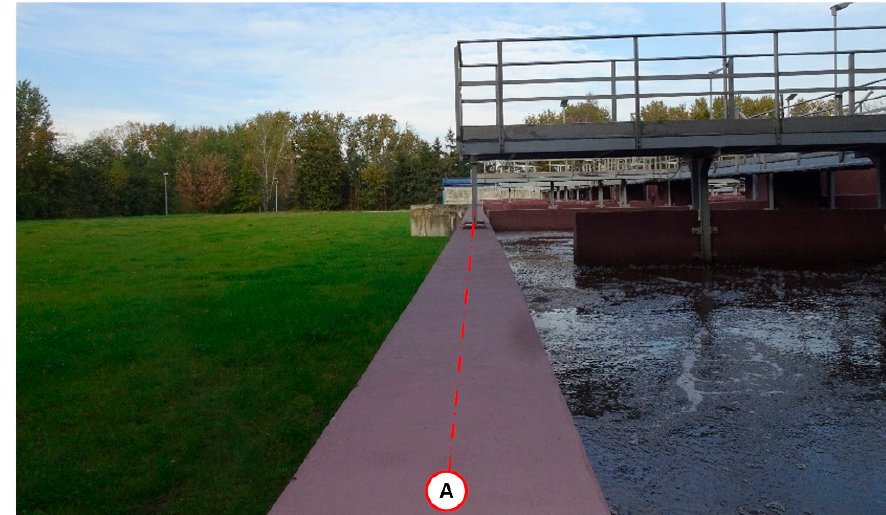
Figure 25. Wall view after